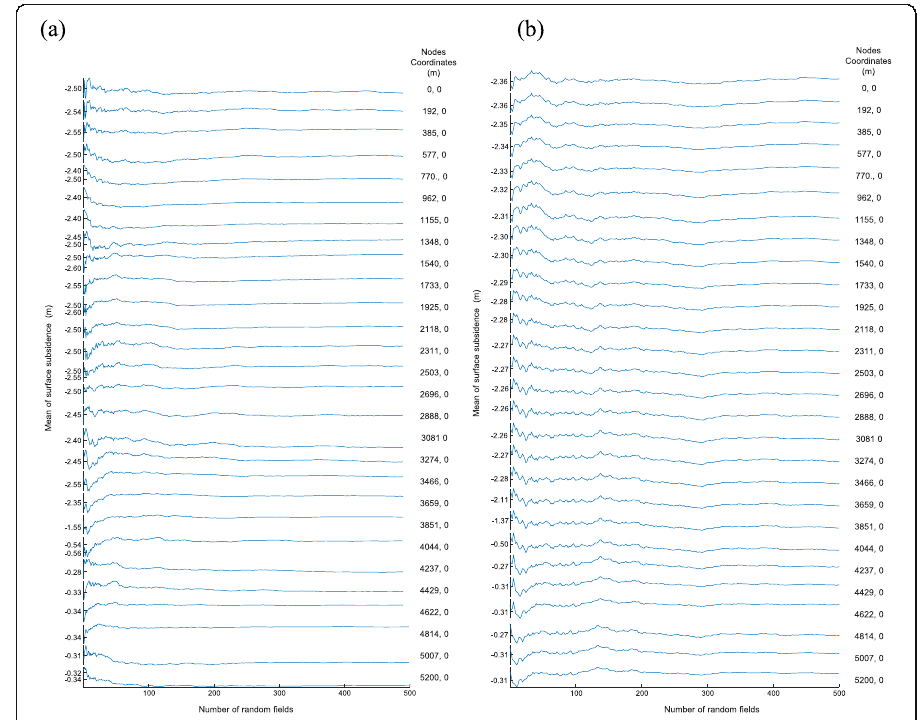
Fig. 3 Effect of the number of random fields on the mean values of subsidence at surface nodes. a Random field of E a (case 1, l x = 200 m, l z = 40 m). b Random field of k a (case 2, l x = 200 m, l z = 40 m)